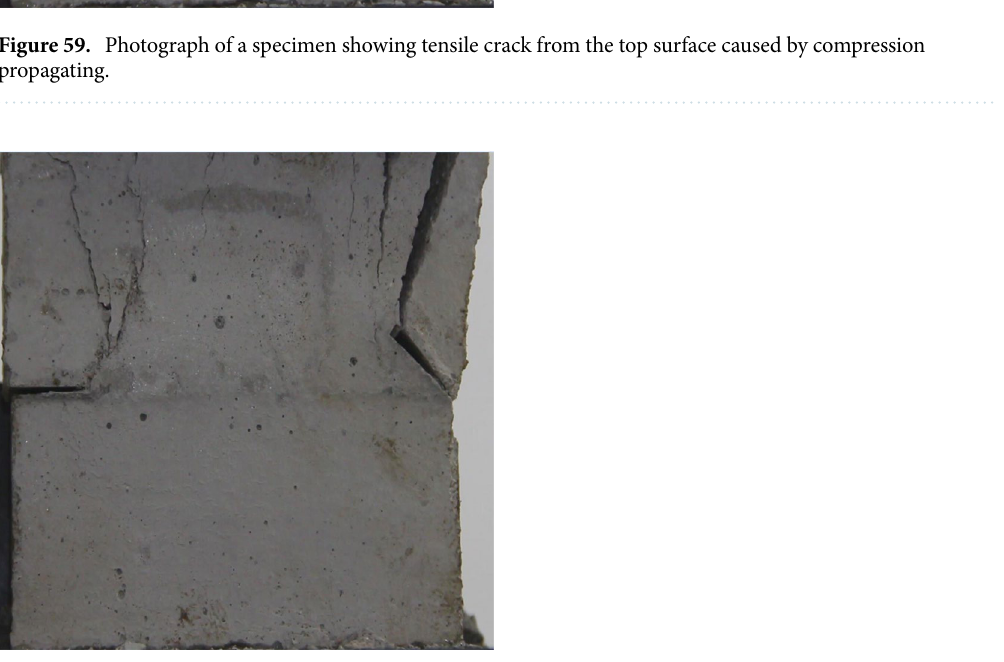
Figure 60. Photograph of a specimen showing tensile crack from the top surface caused by compression